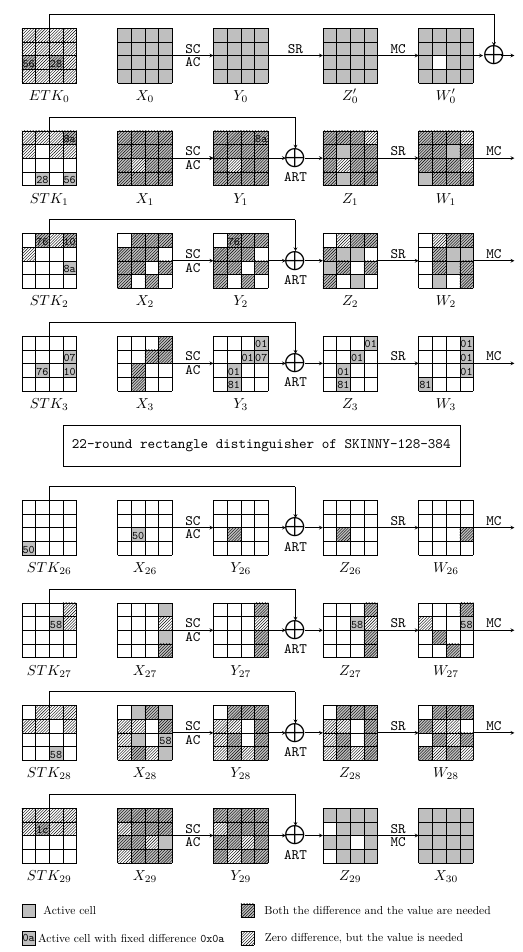
Figure 9: The 30-round attack against SKINNY-128-384